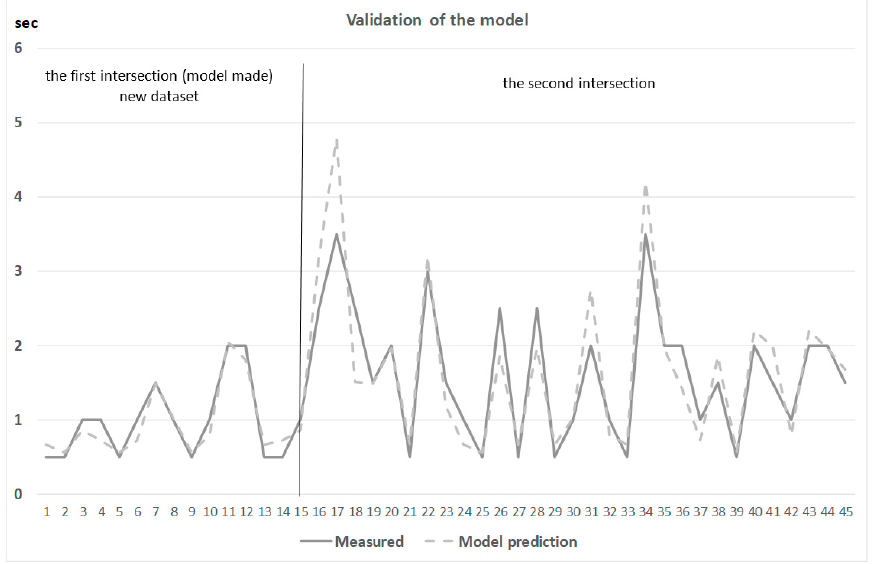
Figure 7. Model validation results - comparison of measured and modeled data.